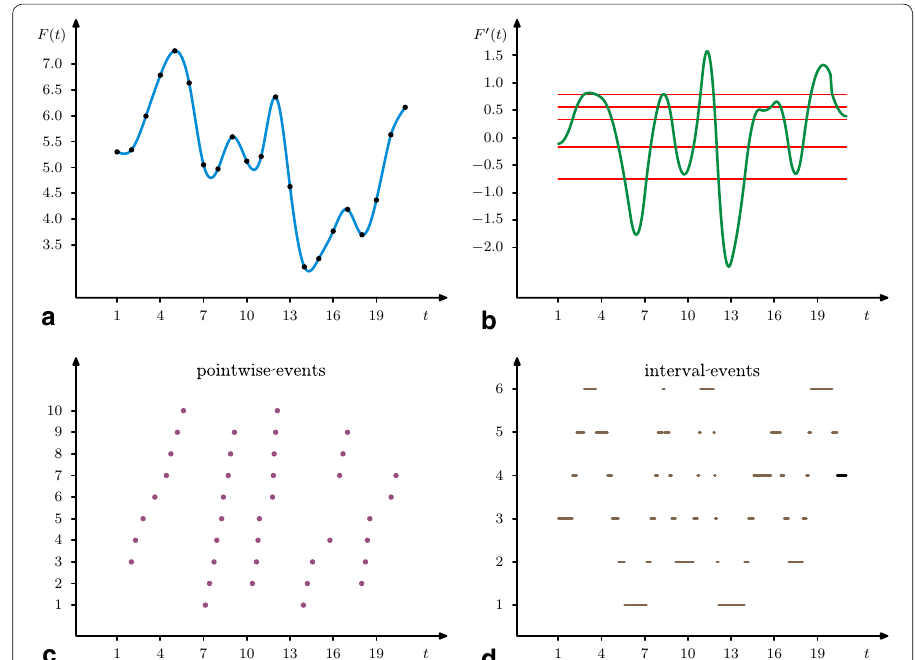
Fig. 2 Conversion of the continuous function F ( t ) into a time series of pointwise or interval based events. a Interpolation from a set of time points, b a derived function F ′ ( t ) with a set of levels important for the problem (red lines), c pointwise and d interval-based